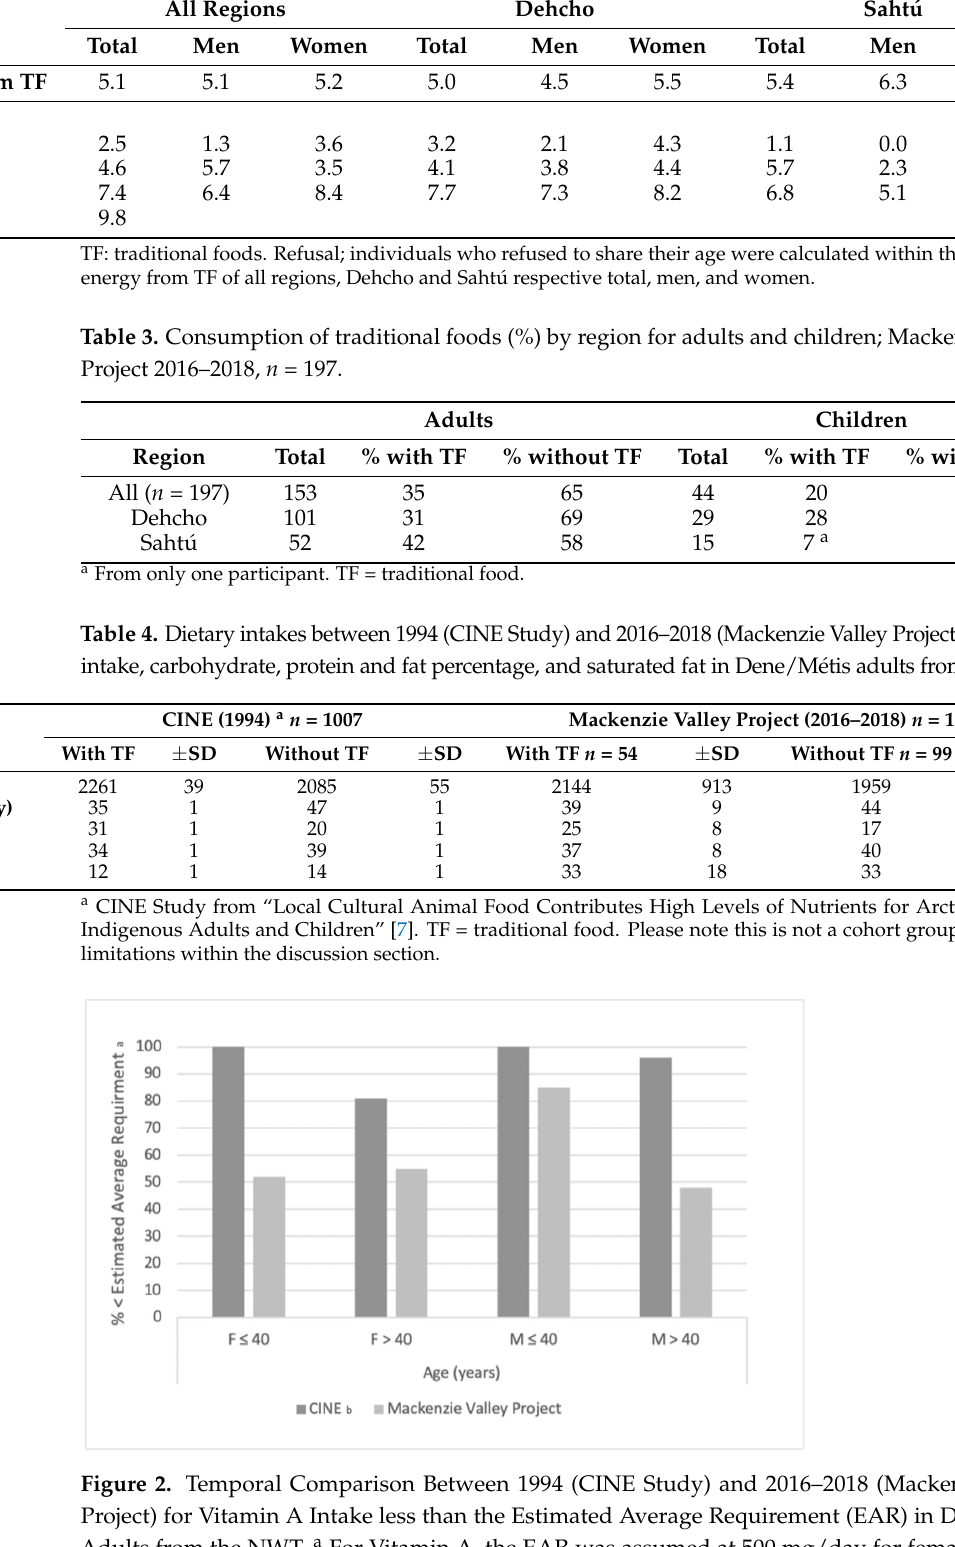
Figure 3. Temporal comparison between 1994 (CINE Study) and 2016–2018 (Mackenzie Valley Pro- ject) for Vitamin D intake less than the adequate intake (AI) in Dene/Métis adults from the NWT. a For Vitamin D, the AI was assumed at 5 mg/day for F and M ≤ 40 and 10 mg/day for F and M > 40. b From “Vitamins A, D, and E in Canadian Arctic traditional food and adult diets.’’ [54]. F = female; M = male 4. Discussion In this study, we describe the consumption of traditional and market foods from the Mackenzie Valley study and present the data alongside the consumption patterns cap- tured by the CINE publications. To our knowledge, it is one of few studies reporting up- to-date dietary intake of traditional foods and market food for the Dehcho and Sahtú re- gions of the NWT. The present study’s observations display that traditional food appears to continue to be consumed in the Dehcho and Sahtú region diets, based on macronutrient